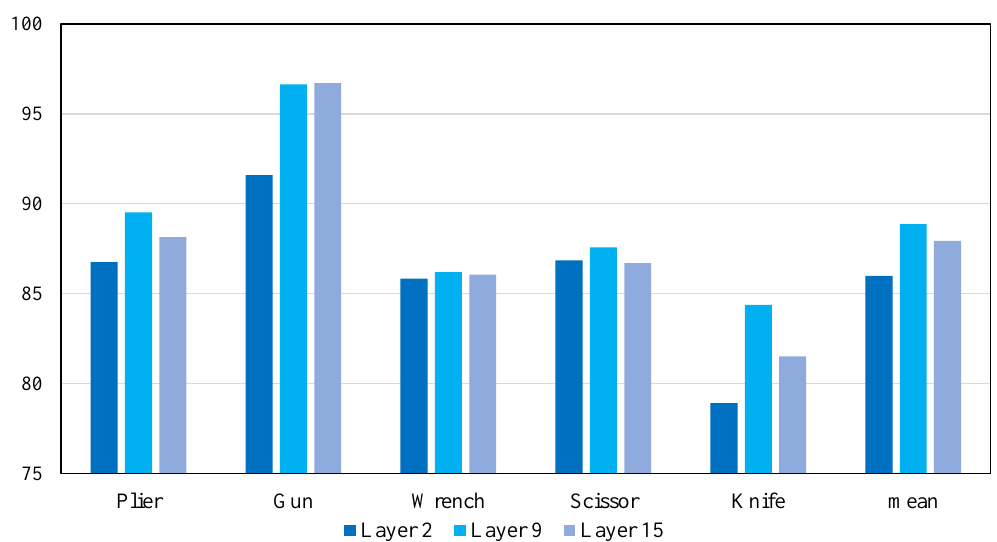
Figure 10. Ablation study: detection AP over each class (and the mean) of SIXray-D dataset using the RFB + TDC detection pipeline. The feature outputs are varied from the layer 2 to 15 of the RFB Net, which are used to crop the X-ray images using TDC, thus generating different detection